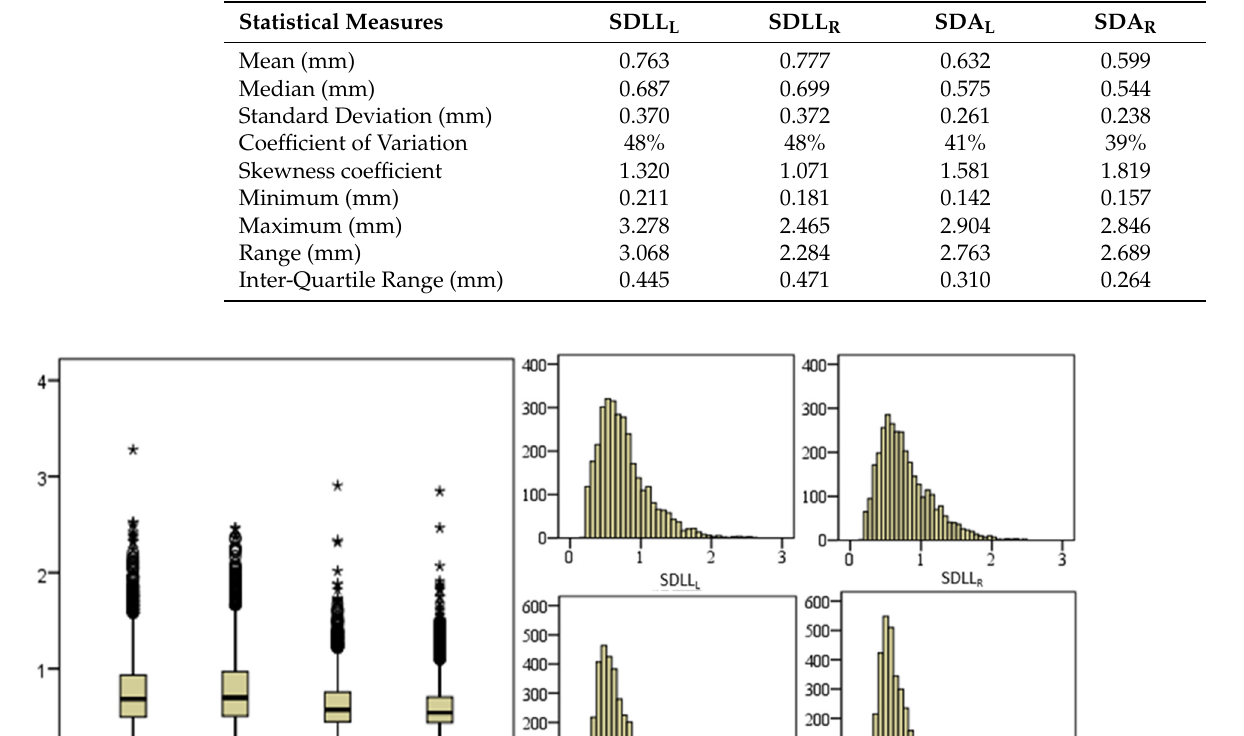
Table 1. Descriptive statistical measures of the standard deviations of the longitudinal level and the alignment of right and left rails.